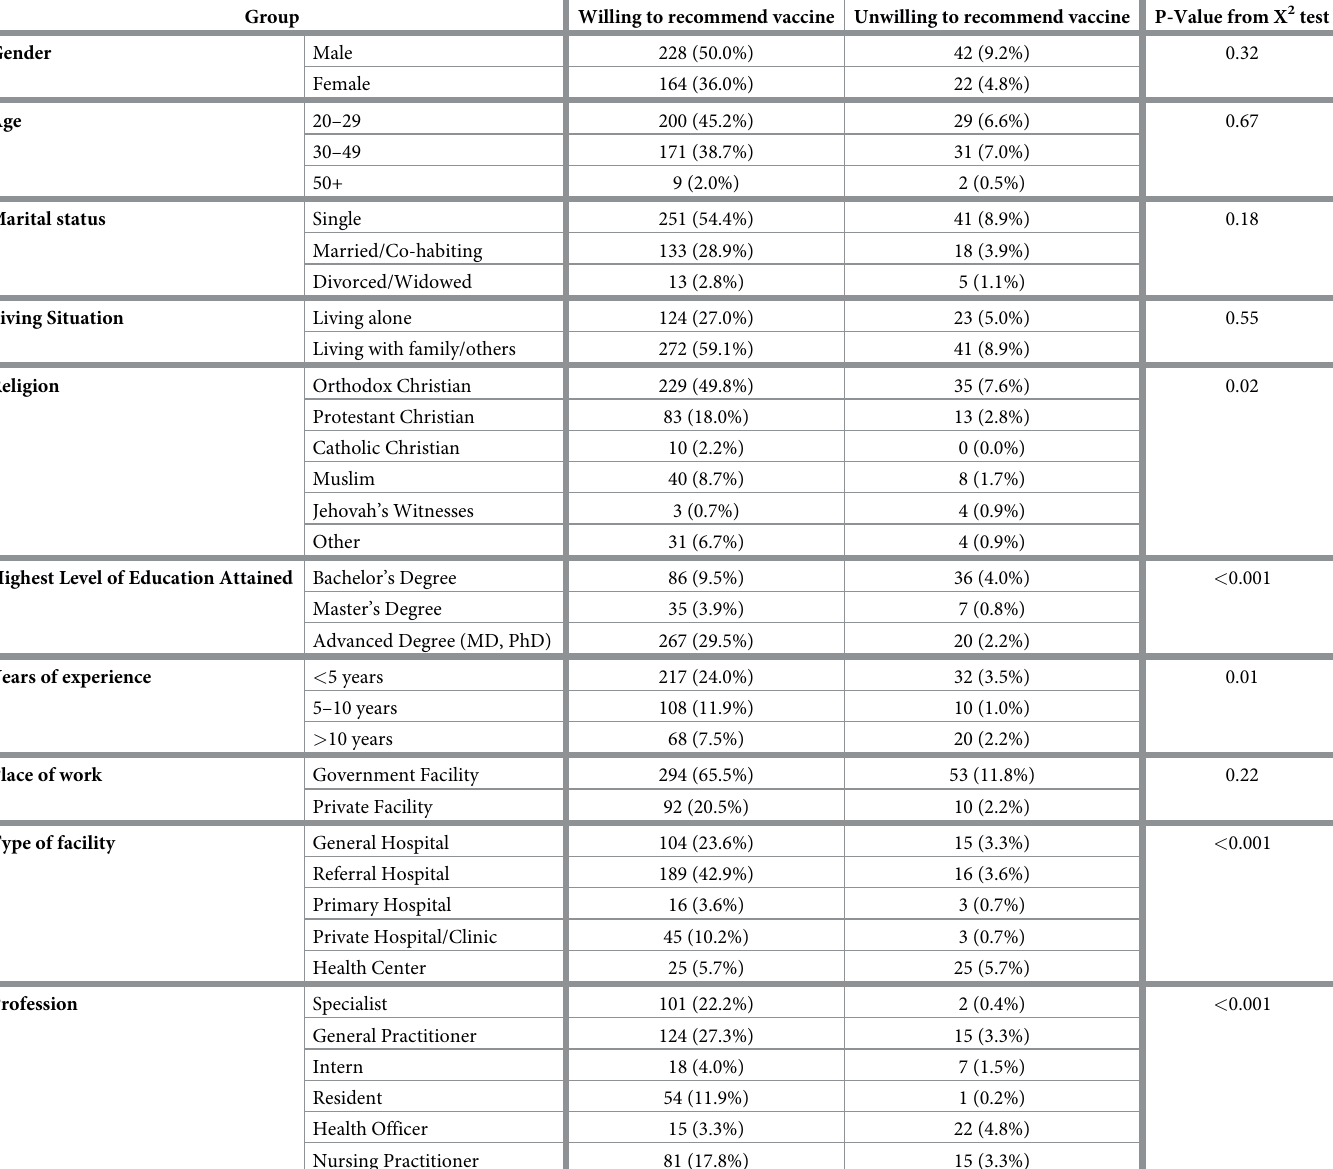
Table 3. Association data between the willingness to recommend the vaccine and the different demographic groups of our survey participants.